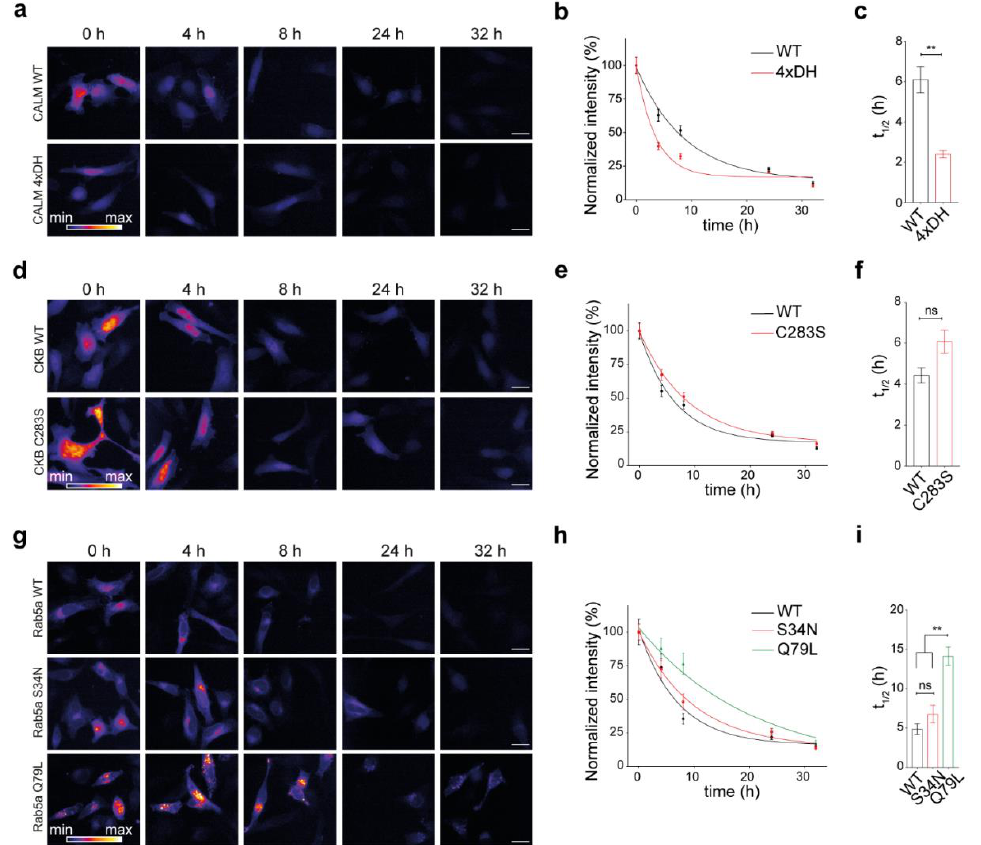
Figure 4. Effect of protein activity on lifetimes for three representative proteins and their respective mutants. ( a ) Representative images of the fluorescence signal intensity over time in the fusion sensor combining the SNAP-tag with either calmodulin WT (CALM WT) or the calmodulin mutant unable to bind Ca 2+ (CALM1 4xDH). ( b ) The quantification of the TMR-BG intensity over time normalized to 0 h. ( c ) Calculated half-lives for ( b ). ( d – f ) as panels ( a – c ) for the turnover sensor creatine kinase B WT (CKB WT) and its kinase-dead mutant (CKB-C283S). ( g – i ) as panels ( a – c ) for the small GTPase Rab5a (WT) and its mutants S34N (inactive), and Q79L (constitutively active). Scale bars: 25 µm ( a , d , g ). The data are presented as mean ± 95% CI ( b , e , h ) or mean ± SEM ( c , f , i ), n = 3. Unpaired Student’s t -test ( c , f ), one-way ANOVA followed by post hoc Tukey’s test ( i ), ns-not significant, ** p < 0.01.